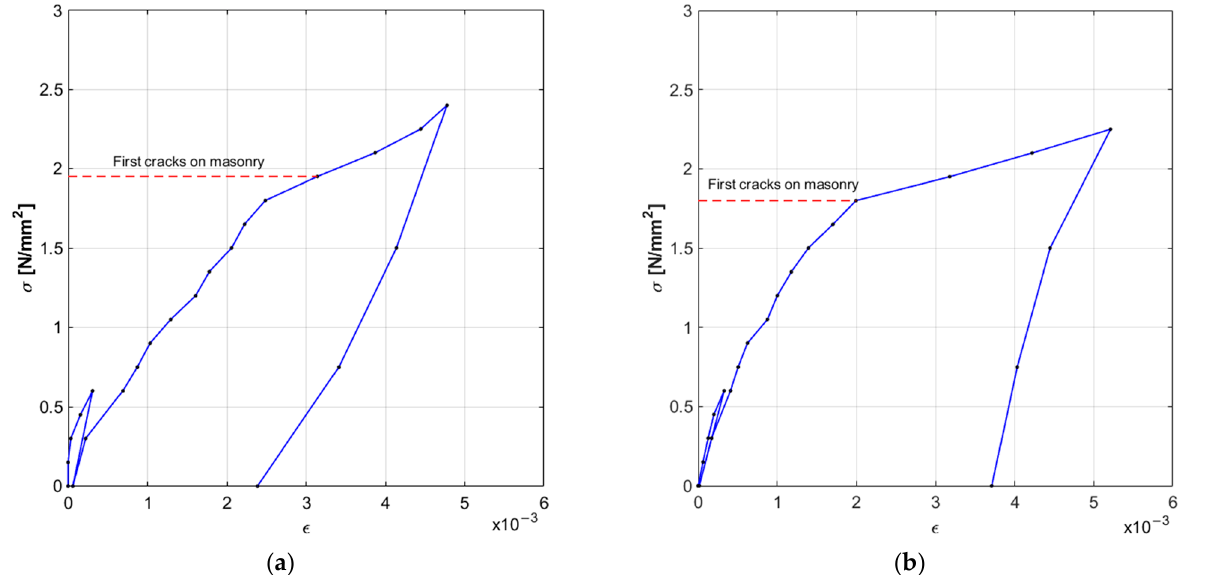
Figure 7. Stress deformation diagrams obtained by the two double flat jack tests: ( a ) DFJ1, ( b )